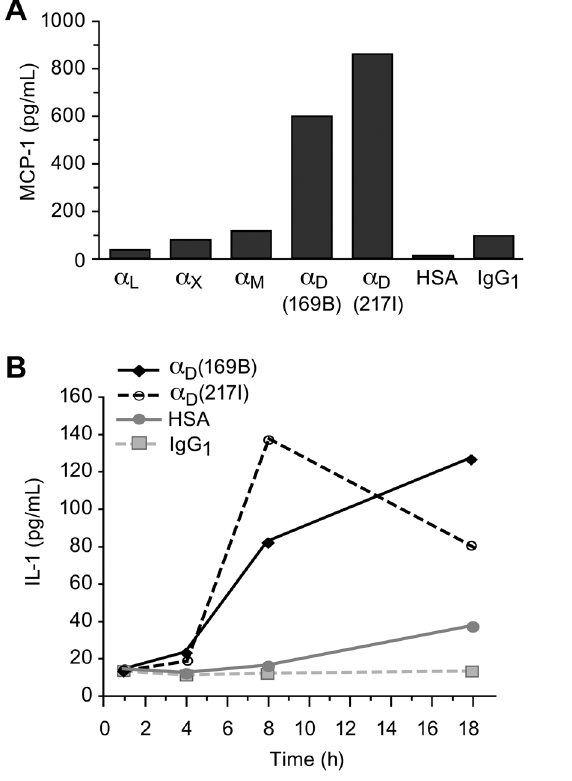
Figure 6. Engagement of integrin a D b 2 triggers expression of inflammatory chemokines and cytokines by human monocytes. Integrin a D b 2 was engaged by immobilized activating mAb and supernatants for mediator analysis were collected as outlined inFigure 5. In (A) the concentration of anti- a D mAb, mAb against other leukocyte integrin a subunits, or control proteins used to coat the wells was 10 m g/ml, and in (B) the concentrations were 20 m g/ml. A. Engagement of integrin a D b 2 (8 hr) triggered release of MCP-1 that was much greater than that induced by immobilized mAb against other leukocyte integrin a subunits or release from monocytes incubated on control surfaces. Two activating anti- a D mAb, 169B and 217I, were studied. This result is representative of the pattern seen in eight separate experiments using monocytes from different donors, as shown in detail in Table S5. B. Engagement of integrin a D b 2 induced time-dependent release of IL- 1 b by monocytes. Two activating anti- a D mAb were examined, as in (A). In five additional experiments using monocytes from different donors, IL-1 b protein was induced in monocyte lysates and released into the supernatants when integrin a D b 2 was engaged for 8 hr., and was greater than that in samples from monocytes incubated on control surfaces (Table